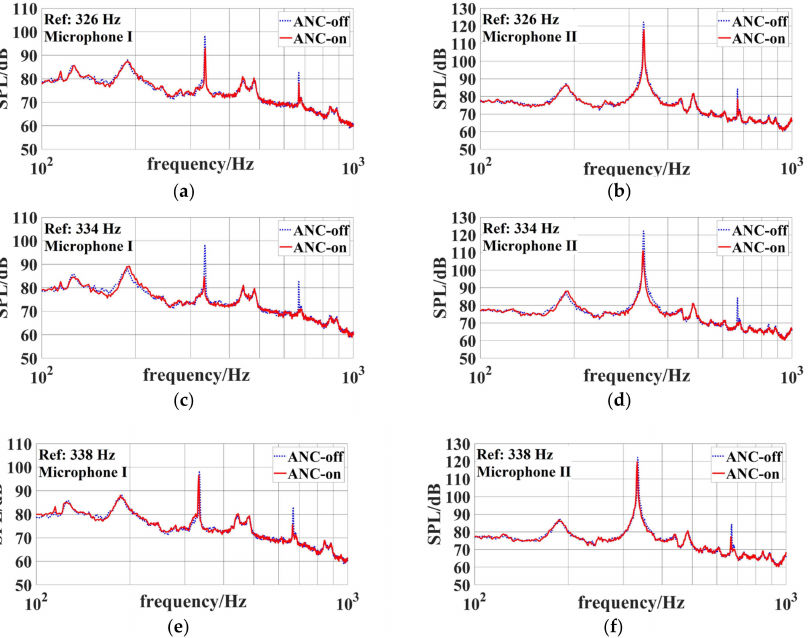
Figure 9. Experimental results with 249 mm cavity: the noise spectrum at the test ( a ) microphone I and ( b ) microphone II with a 326 Hz reference; the noise spectrum at the test ( c ) microphone I and ( d ) microphone II with a 334 Hz (resonance frequency) reference (best); the noise spectrum at the test ( e ) microphone I and ( f ) microphone II with a 338 Hz